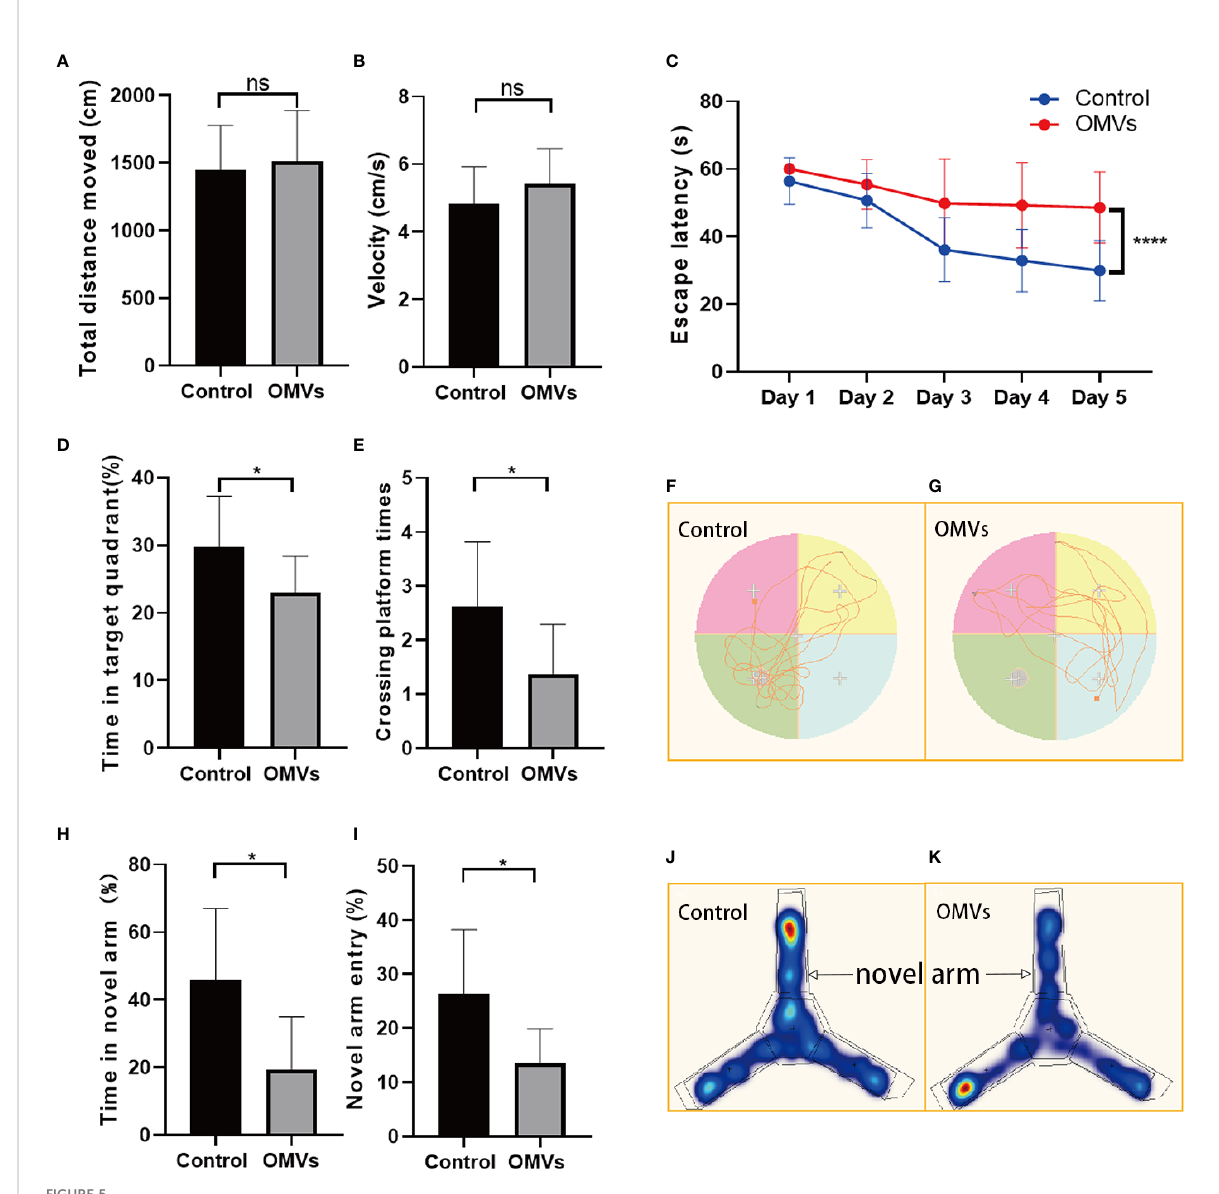
FIGURE 5 Oral gavage of Pg OMVs impairs memory and spatial learning of mice. (A, B) Distance and velocity traveled in the open- fi eld test. (C) Latency to fi nd the platform during the acquisition phase of the MWM test. (D, E) Crossing platform times and time in the target quadrant on the sixth day when the platform was removed. (F, G) Representative tracing graphs of Morris water maze on the sixth day. (H, I) Novel arm entry and time spent in the novel arm in the Y-maze test. (J, K) Representative hot spot graphs. ( n = 8, ns: P >.05, * p <.05, **** p